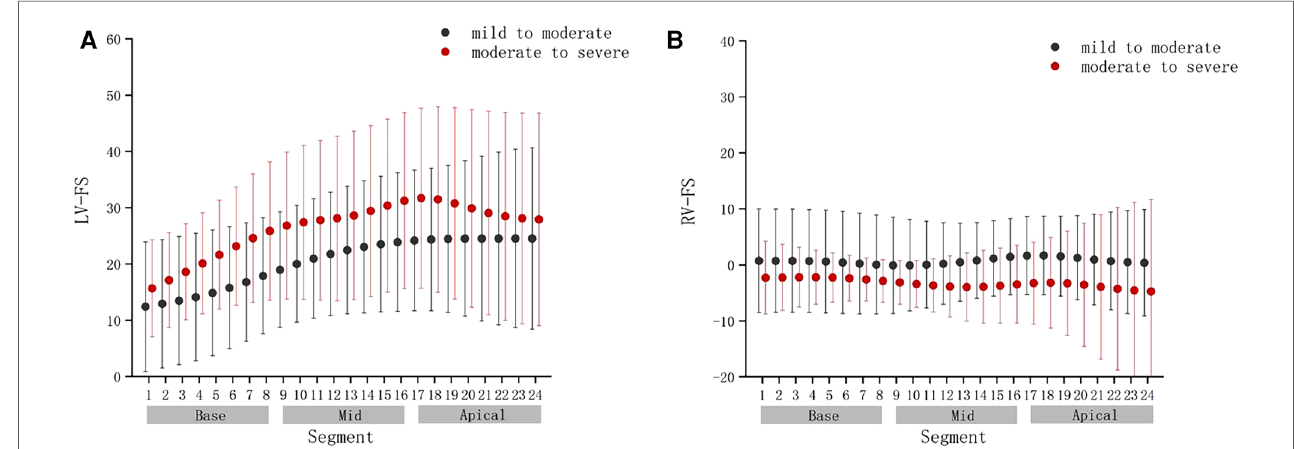
FIGURE 9 Comparison of ventricular 24-segment fractional shortening (FS) from the base to the apex between the mild to moderate group and moderate to severe group. ( A ) Left ventricle (LV) 24-segment FS values in the mild to moderate group and moderate to severe group. ( B ) Right ventricle (RV) 24-segment FS values in the mild to moderate group and moderate to severe